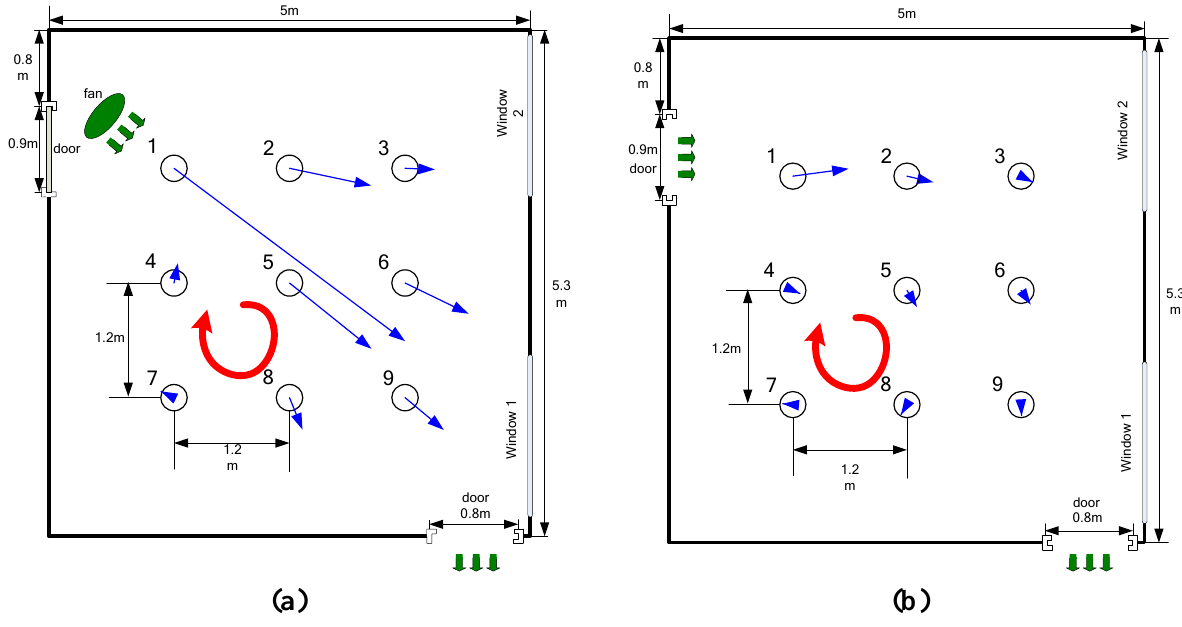
Figure 13. The average wind speed and direction of each anemometer over 300